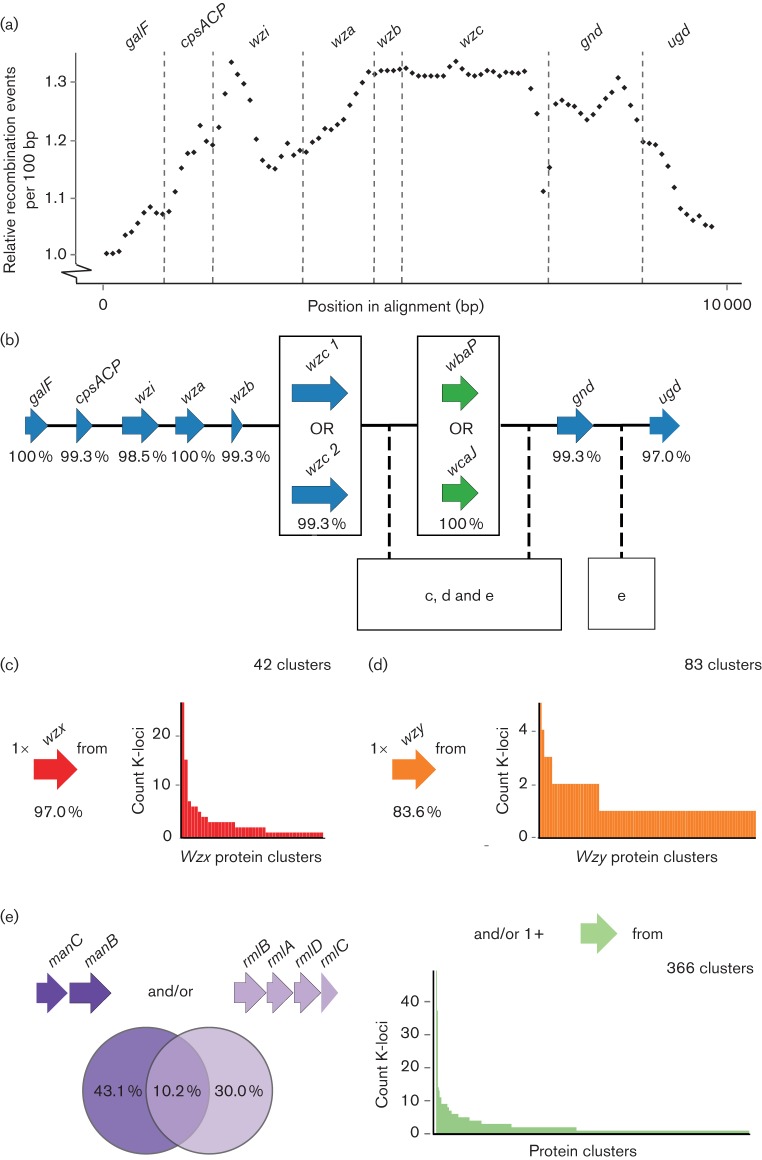
Composition and diversity of Klebsiella K-loci. (a) Putative recombination events among the common K-locus genes. Values plotted are the relative number of events per 100 bp window, inferred using ClonalFrameML. (b) Representation of a generalized K-locus structure. Arrows represent K-locus coding regions coloured by predicted protein product as in Fig. 2. Percentage values indicate the number of reference K-loci containing each gene (total 134 references). Note that 13 of the K-locus references partially or completely exclude ugd, although it is known to be present in 11 of these loci (Pan et al., 2015). Thus, these 11 were counted as containing ugd. (c, d, e) Diversity of proteins encoded by wzx (c), wzy (d) and sugar processing genes (e) annotated amongst the 134 K-locus reference sequences. The locations within this structure at which wzx (c), wzy (d) and sugar processing genes (e) have been found to occur are indicated. Bar charts indicate the frequency of each predicted protein cluster.